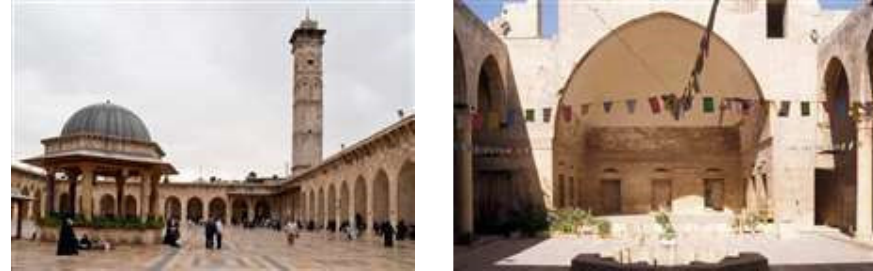
Fig. 2: Courtyard, a- Courtyard, The Great Umayyad Mosque, Aleppo, Syria (Fangi and Wahbeh, 2013), b- Courtyard, Al-Firdaws mosque-madrasa, Aleppo, Syria (Hammad, 2004)